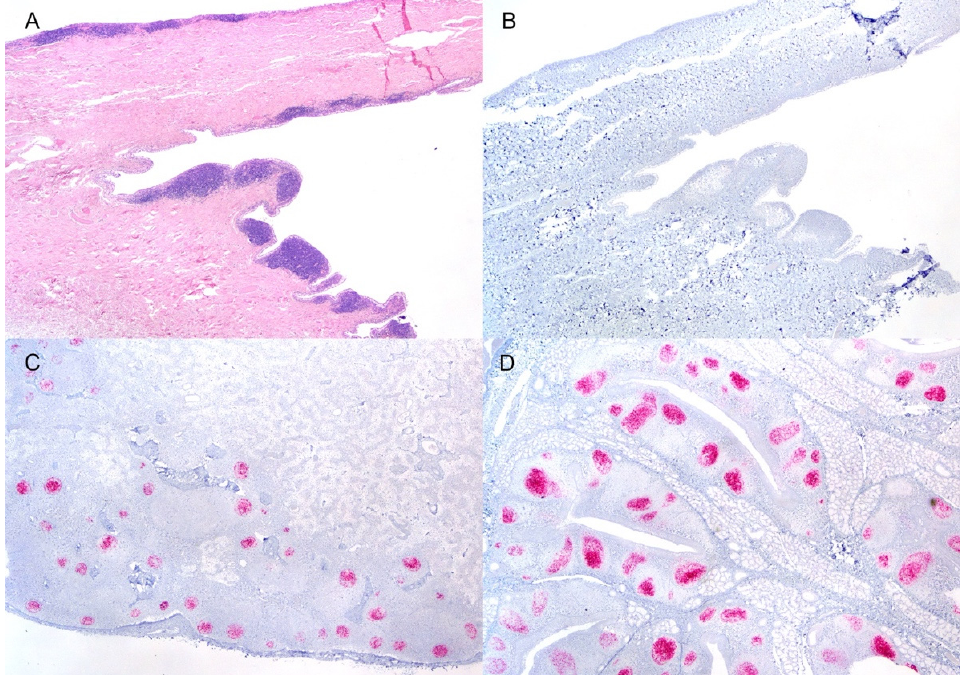
Figure 1. Demonstration of PrP Sc in lymphoid tissue of a white-tailed deer inoculated with raccoon- passaged CWD. ( A , B ) Lymphoid aggregates are prominent in the nictitating membrane of this deer; however, no positive immunolabeling is demonstrable. There is abundant immunolabeling of PrP Sc (red) in the retropharyngeal lymph node ( C ) and palatine tonsil ( D ). ( A ), hematoxylin and eosin. ( B – D ), immunohistochemistry, F99 monoclonal antibody. Original magnification ( A – D ), 20×.